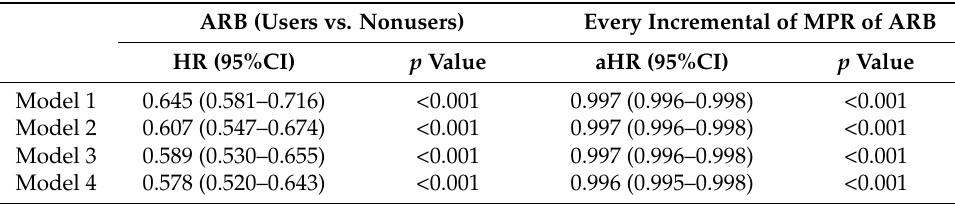
Figure 2. Kaplan–Meier cumulative event-free plots of dementia. A significant difference in entering dialysis was noted between groups (log-rank test, χ 2 = 68.56, p < 0.001). Table 3. Competing risk analysis of ARB effects on dementia.